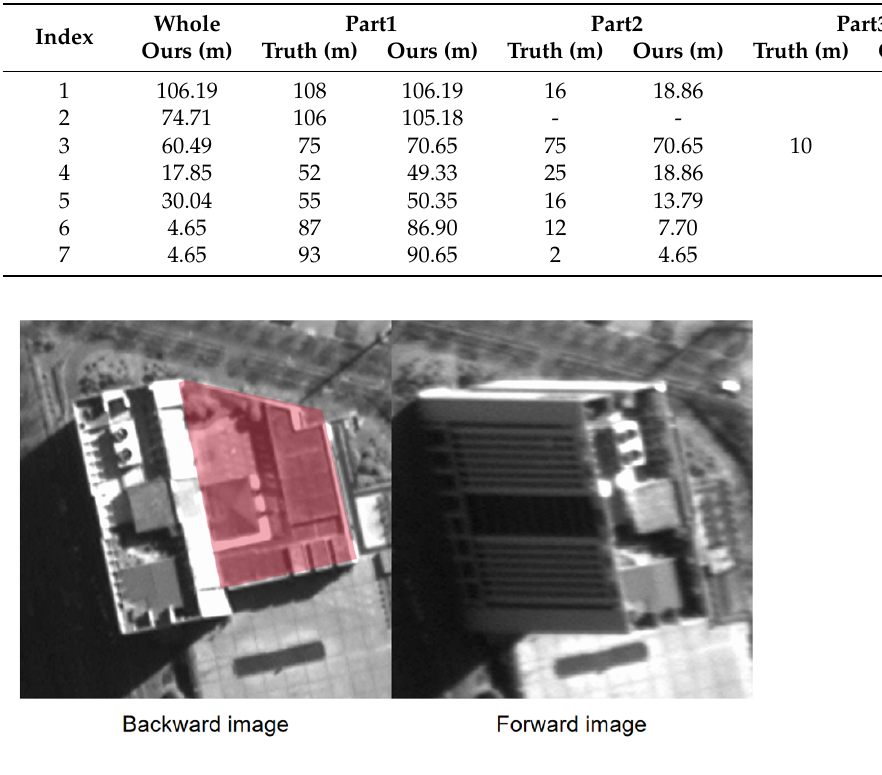
Figure 21. The illustration of the second Podium structure. The red box indicates the coverd part on backward image.